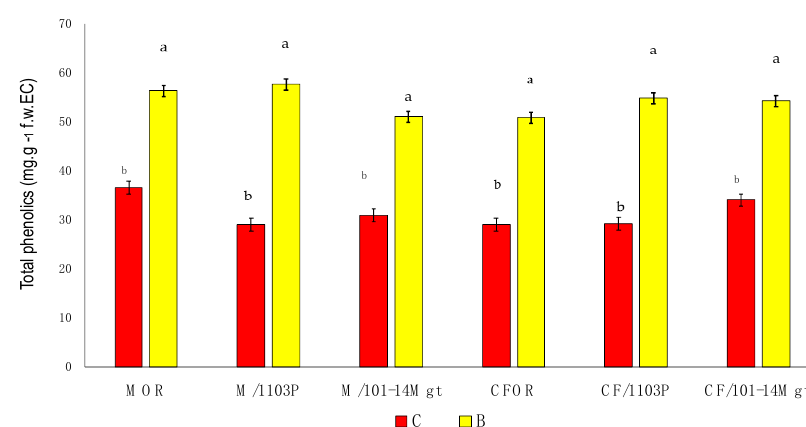
Figure 3. Leaf total phenolic content in Merlot (M) and Cabernet Franc (CF) vine varieties, either own-rooted (OR) or grafted onto 1103P and 101-14 Mgt rootstocks after sixty days of boron treatment. C represents the control treatment; B represents the borontreatment. Different letters represent significant differences at p < 0.05.